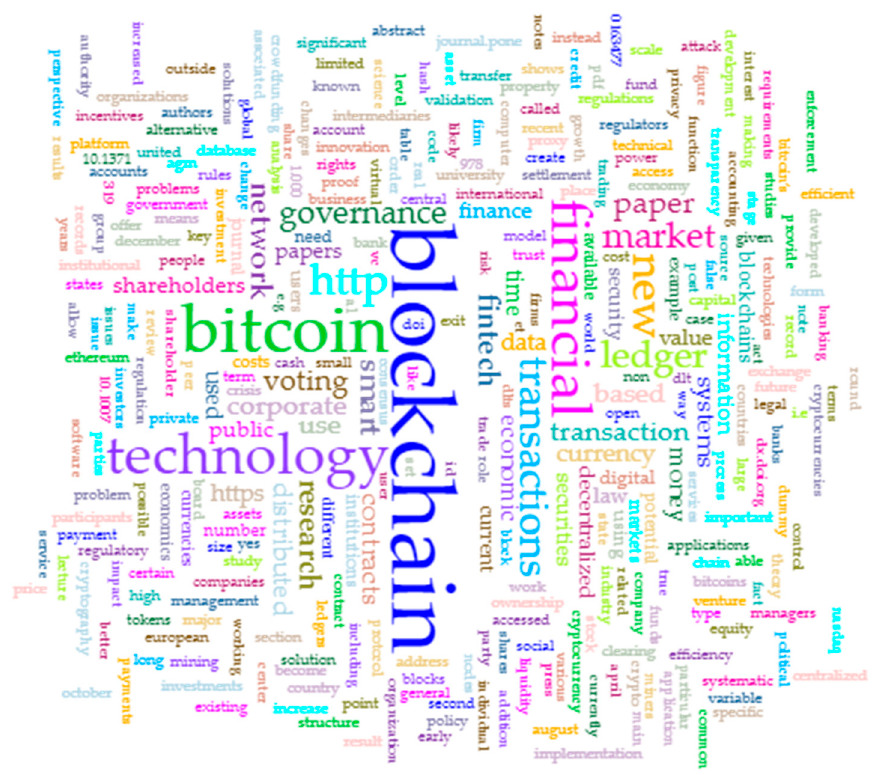
Figure 3. Resource map from textual analysis of both industry and academic literature.